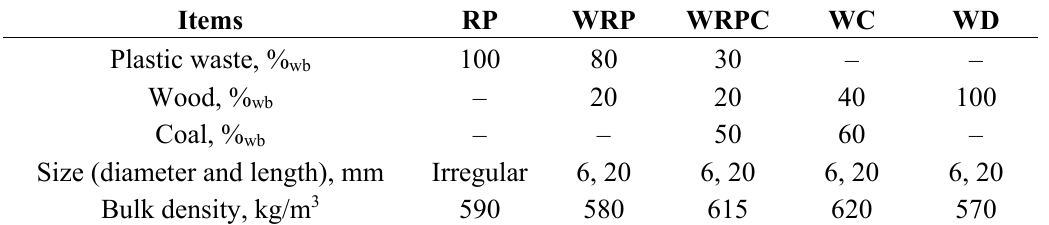
Table 2. Composition and main physical properties of the tested